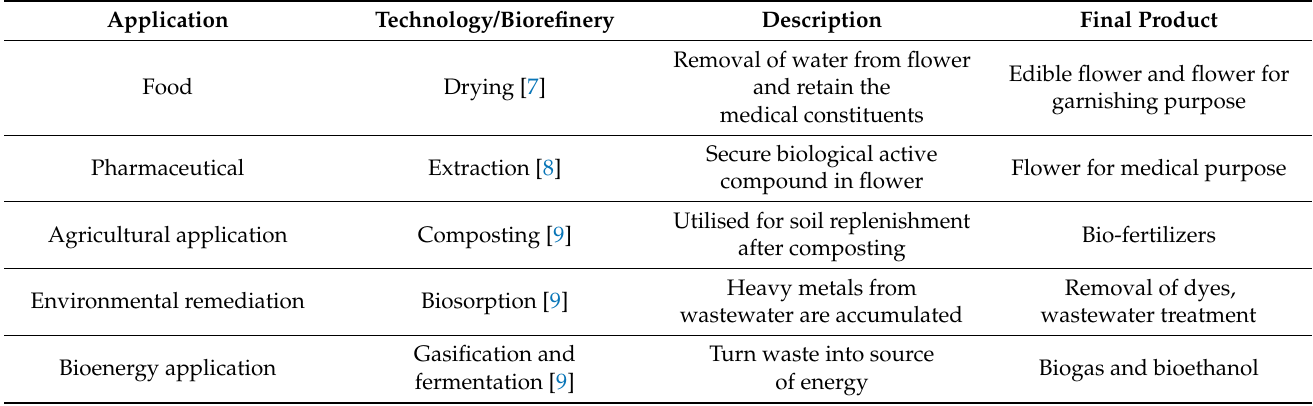
Table 1. Possible technologies for utilisation of flower